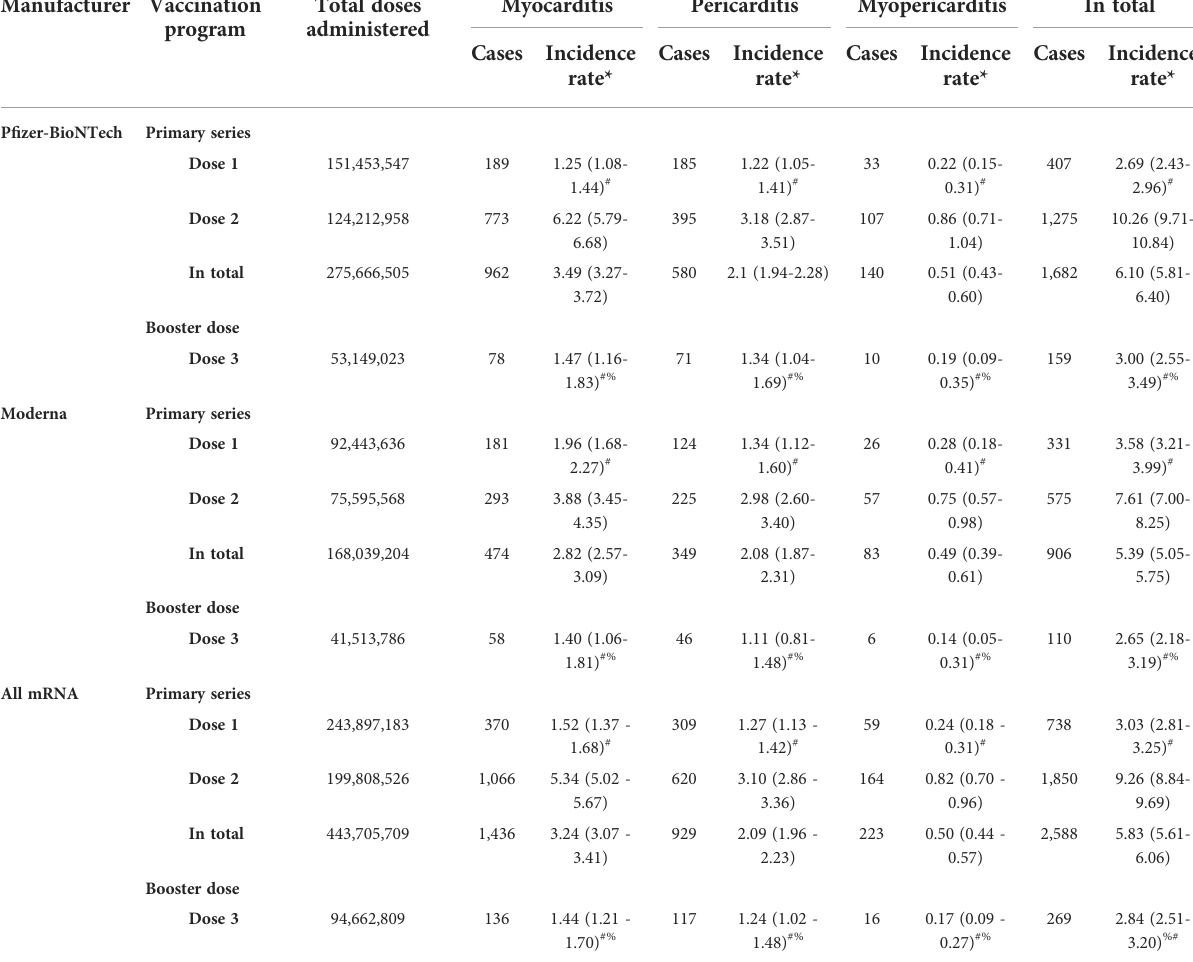
TABLE 1 The incidence rate of casesofmyocarditis/pericarditisby differentCOVID-19mRNA vaccinationprograms basedontotaladministereddose. Manufacturer Vaccination